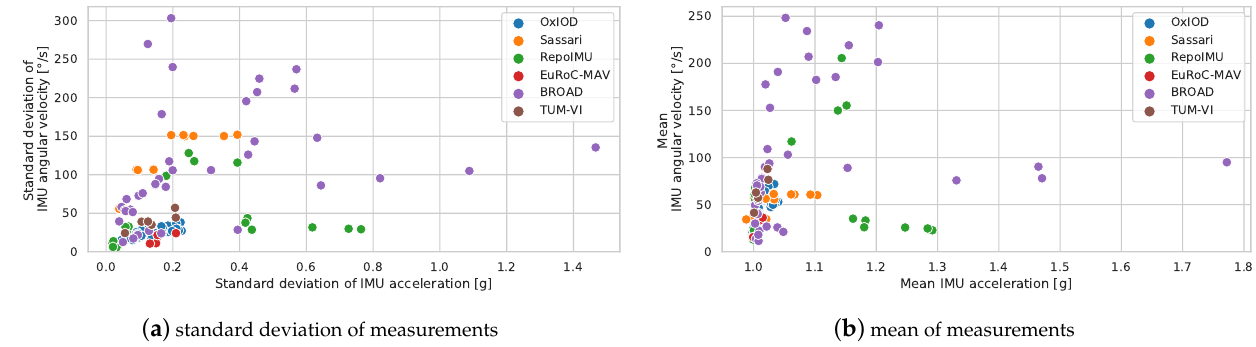
Figure 5. Comparison of motion characteristics of the different datasets. Differences between datasets are considerable. The datasets BROAD, Sassari, and RepoIMU contain motions with a relatively large variety of characteristics.